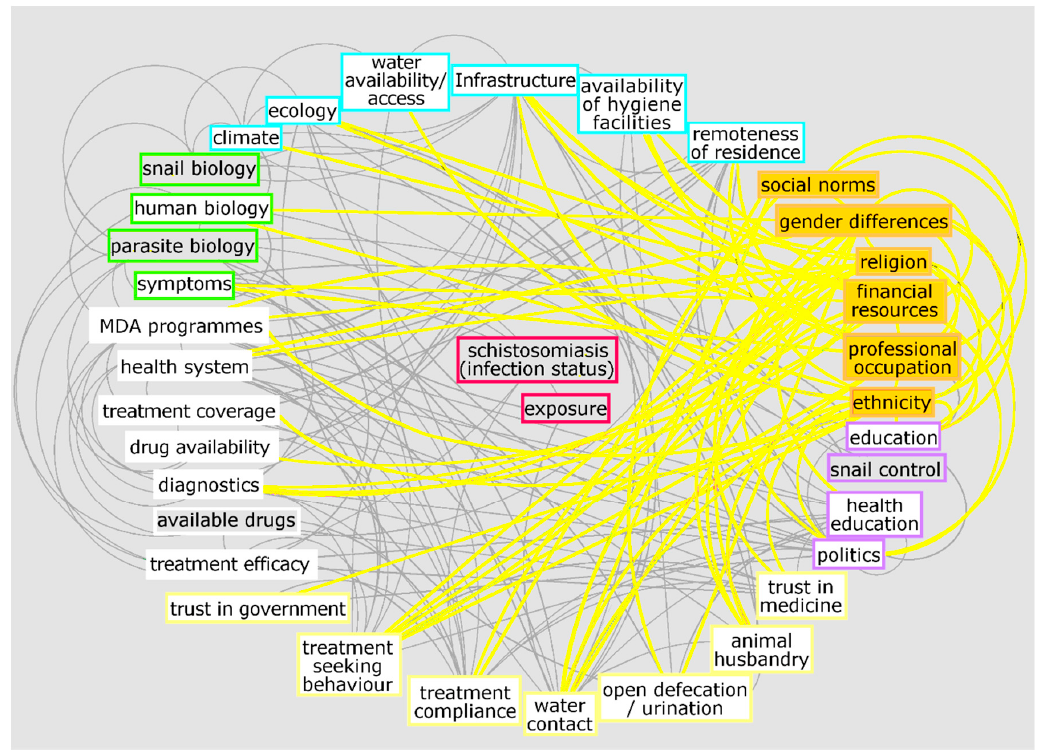
Figure 3. Interconnectedness of social factors with other aspects of the schistosomiasis. White boxes indicate where the highlighted variables connect to. Social aspects illustrated: social norms, gender differences, religion, financial resources, professional occupation, and ethnicity. Although they do not interact directly with infection status or exposure, social aspects underlie and influence many other factors that are, in turn, connected to exposure and infection.